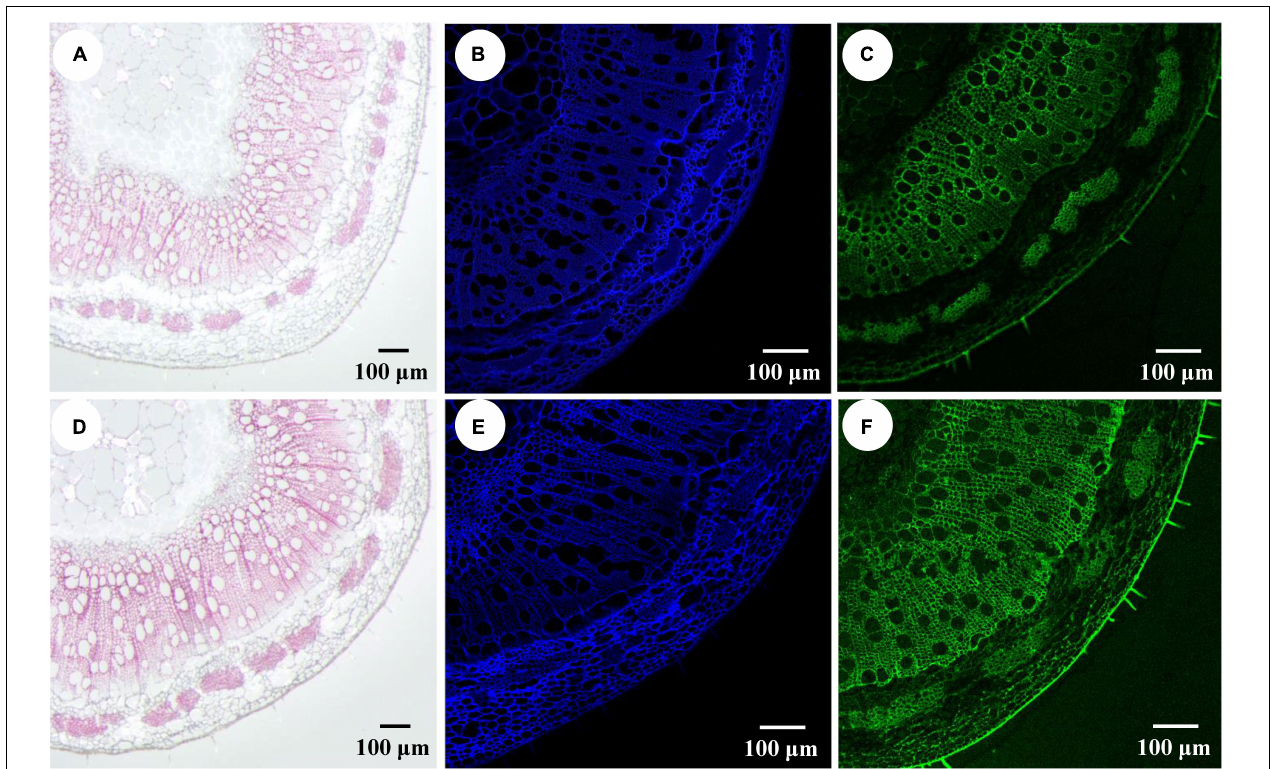
FIGURE 4 | Impact of PtrWOX13A overexpression on components of the secondary cell wall of stems in Populus trichocarpa. (A) Stem section of wild type stained with Phloroglucinol-HCl (red color). (B) Stem section of wild type stained with Calcofluor white staining (blue color). (C) Stem section of wild type stained with Monoclonal Antibody LM10 (green color). (D) Stem section of PtrWOX13A overexpression transgenic lines stained with Phloroglucinol-HCl (red color). (E) Stem section of PtrWOX13A overexpression transgenic lines stained with Calcofluor white (blue color). (F) Stem section of PtrWOX13A overexpression transgenic lines stained with Monoclonal Antibody LM10 (green color). Scale bars = 100 µ m. All data were measured on the 8th stem of 90-day-old